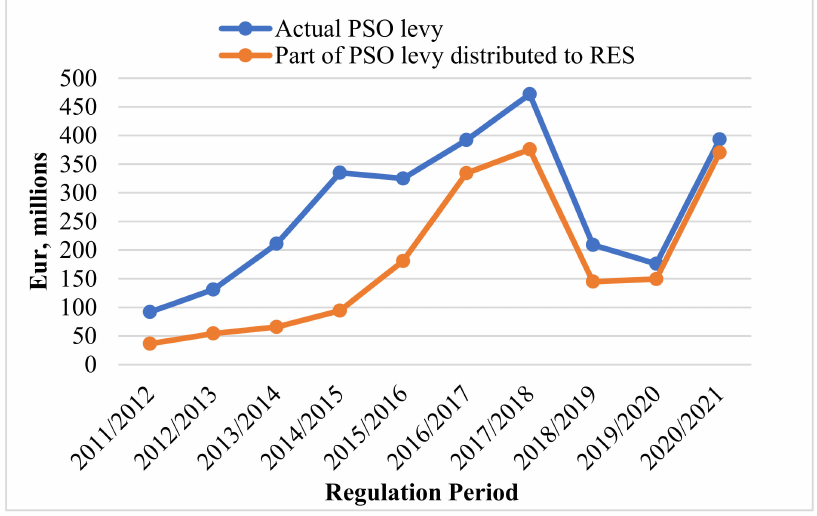
Figure 10. Irish PSO levy and PSO levy distributed to RES 2011–2021 (designed by the authors, based on